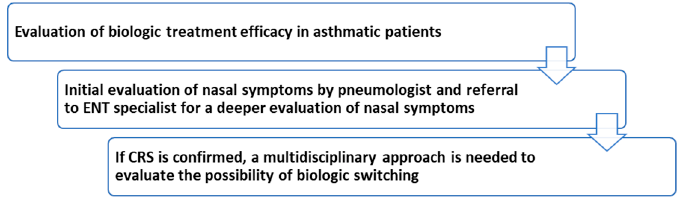
Figure 5. Summary of the second flow. ENT = otolaryngology; CRS = chronic rhinosinusitis.